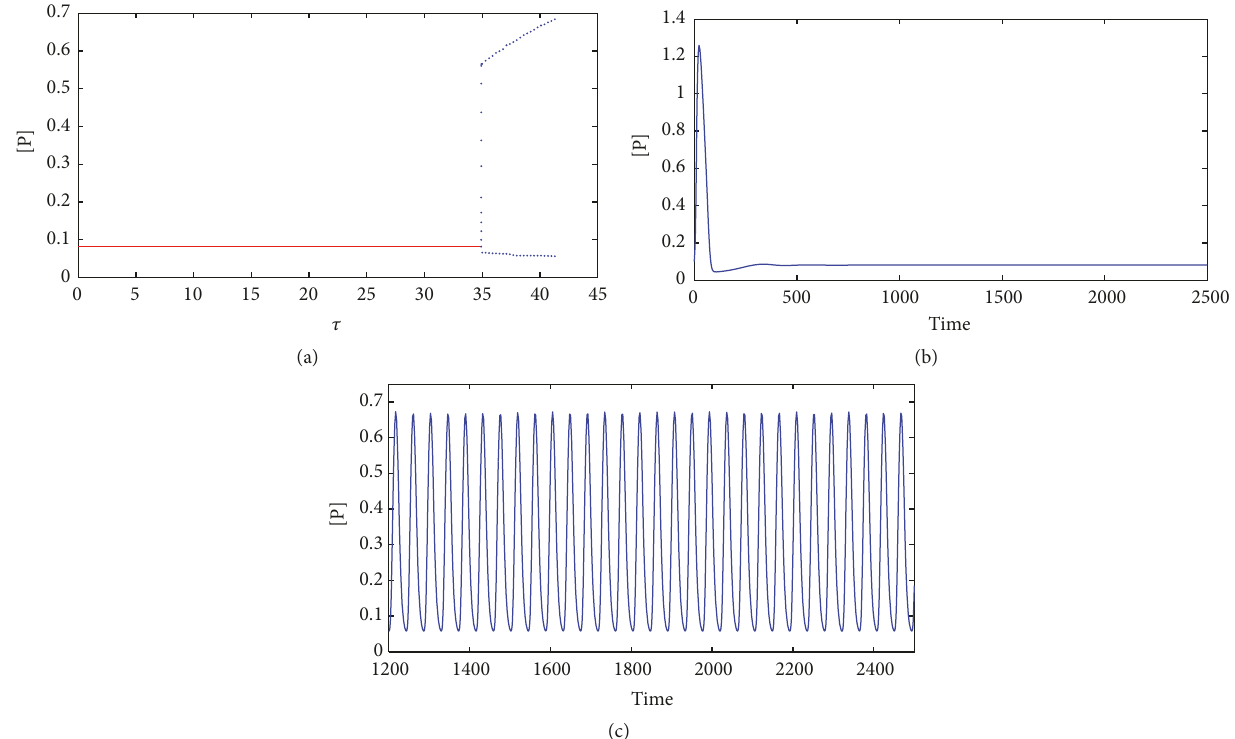
Figure 5: (a) Bifurcation diagram of [P] with time delay 𝜏 as the bifurcating parameter when fixing the negative feedback strength Γ 2 = 0.07 . The red solid line depicts stable steady states and the blue dots depict the maxima and minima for the stable limit cycle. (b) and (c) are time courses diagram of [𝑃] for the parameter 𝜏 = 1 (b) and 40 (c), respectively. Initial conditions: 𝑃(0) = 0.1,𝑀(0) = 0.1